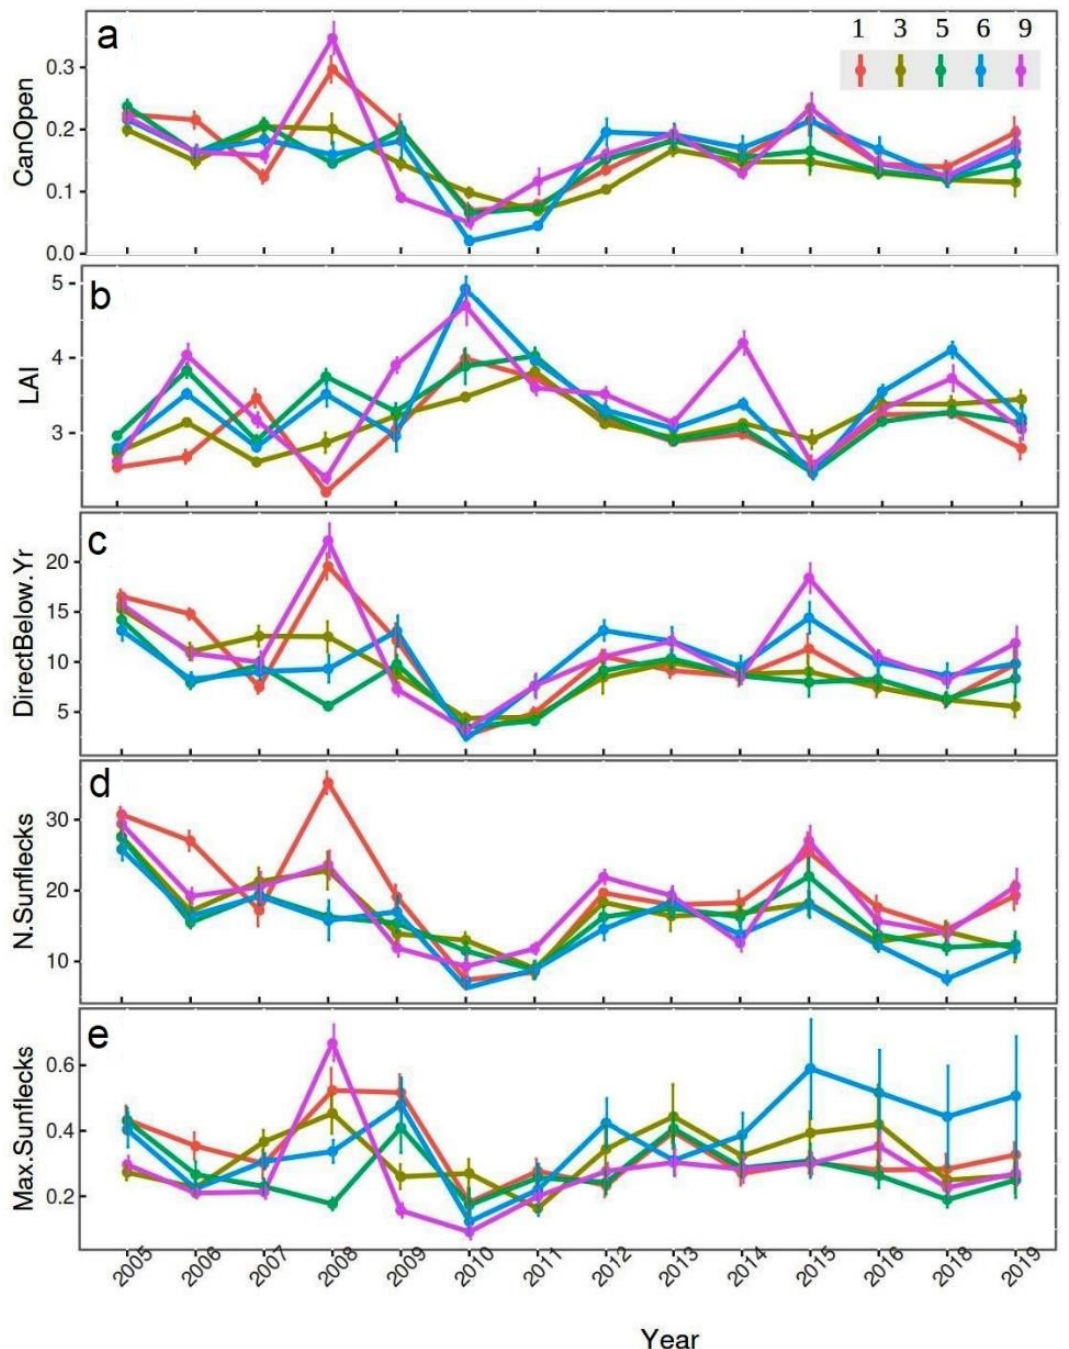
Figure 2. Light variables from the hemispherical photograaphs during the studied years for the five plots that showed Figure 3. Partial autocorrelation functions (PACFs) for light variables over the studied years for the five plots with the larger changes over time: ( a ) CanOpen (parts per unit), ( b ) LAI (m 2 m − 2 ), ( c ) DirectBelow.Yr ( µmol m −2 s −1) , ( d ) N.Sunflecks clearest trends. ( a ) CanOpen , ( b ) LAI , ( c ) DirectBelow.Yr , ( d ) N.Sunflecks , and ( e ) Max.Sunflecks . Each line represents different ( µmol m −2 s −1 ) , and ( e ) Max.Sunflecks (minutes). Each line corresponds to different plots. For each light variable, horizontal plots. The y-axis represents the values the PACF can take (from 1.0 to − 1.0), and the x-axis represents the years. For y-axis, lines represent the mean values whereas vertical lines symbolize standard error. values close to zero (dashed lines) show that there was no temporal autocorrelation of the values of each light variable with respect to the previous